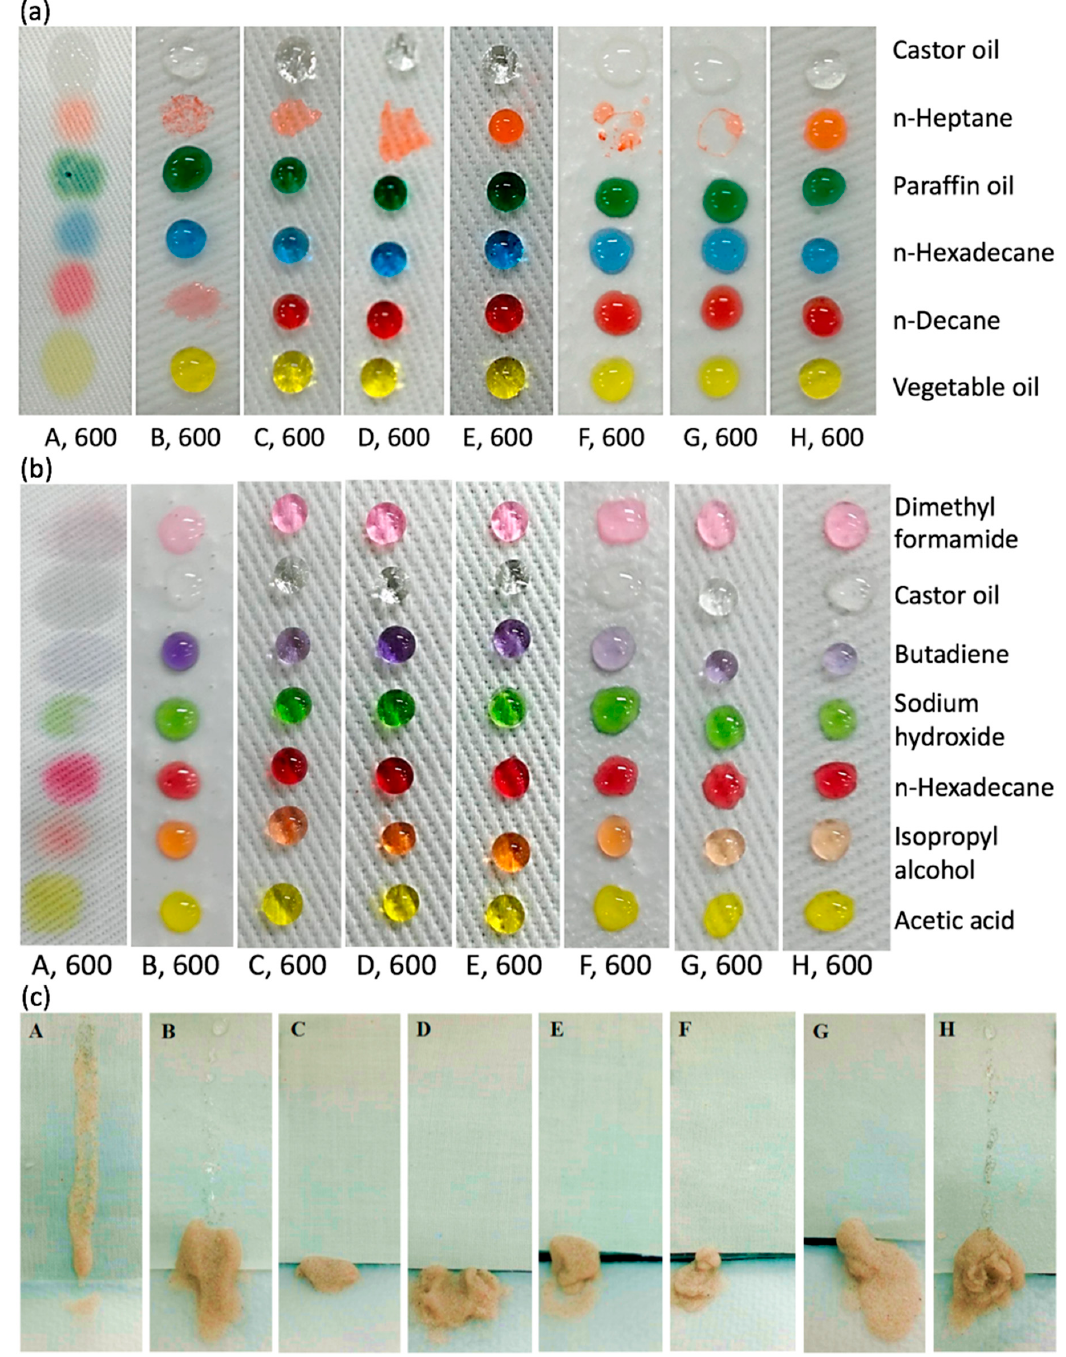
Figure 4. Protection of the as-coated cotton fabrics against oil ( a ), chemicals ( b ) and soil ( c ).